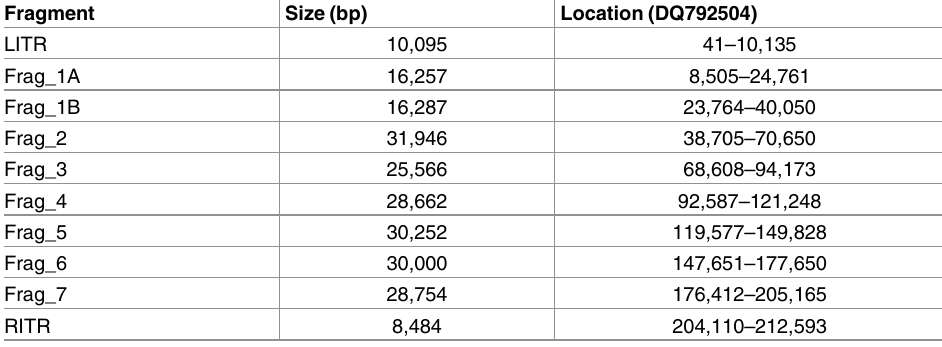
Table 1. Size and location of each synthetic DNA fragment within HPXV (Accession